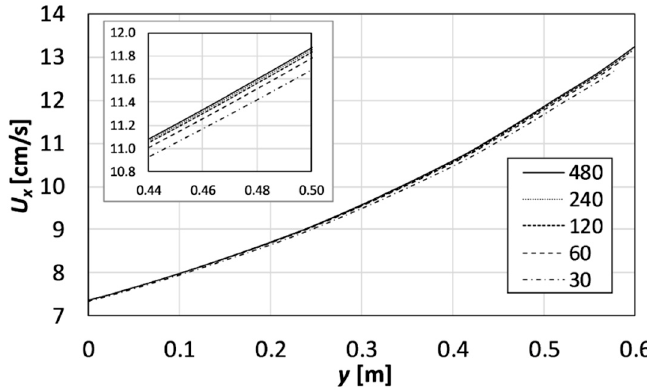
Figure A1. Cross flow configuration at P in = 34.3 kPa: profiles of the x -velocity component along a line orthogonal to the main flow direction and located 2 cm away from the inlet, see Figure 8a. Results obtained with five grids of increasing resolution are reported. The inset shows a magnified portion of the same plot.